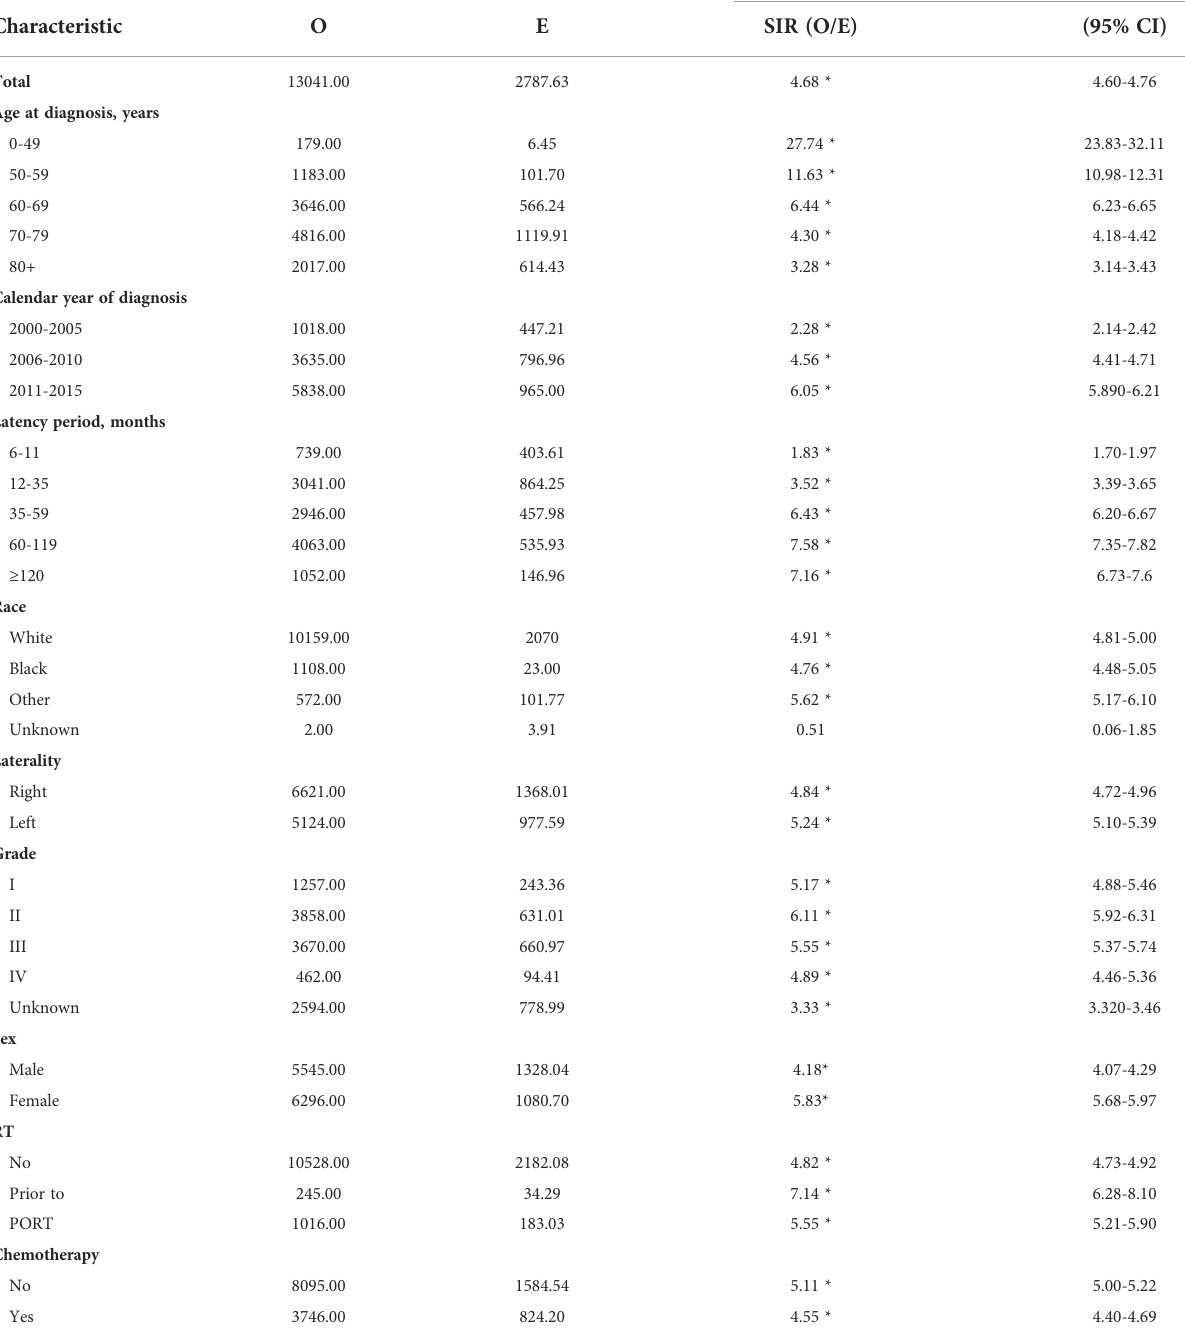
Standardised incidence rate